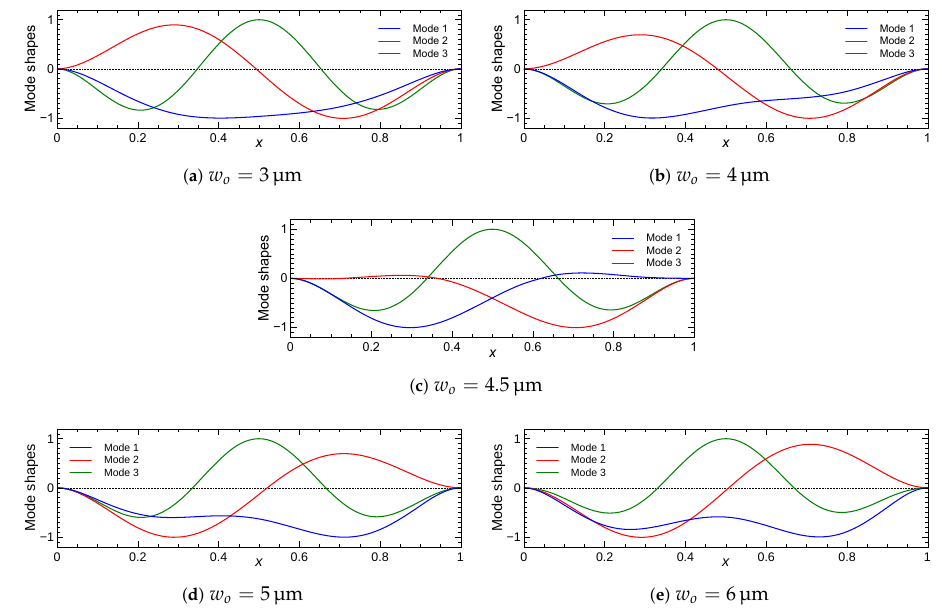
Figure 10. Shapes of the first three modes subject to a DC voltage of V DC = 15V across a half-electrode for five values of the initial rise w ◦